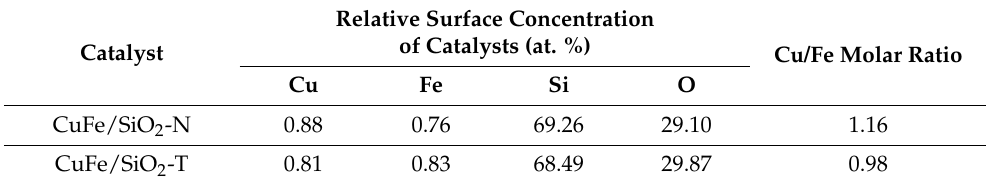
Table 2. XPS results of CuFe/SiO 2 -N and CuFe/SiO 2 -T catalysts. Relative Surface Concentration Catalyst